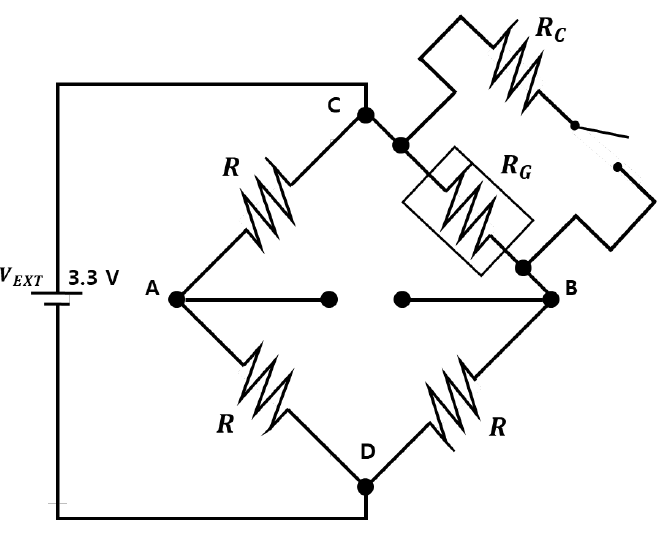
Figure 3. Wheatstone bridge.